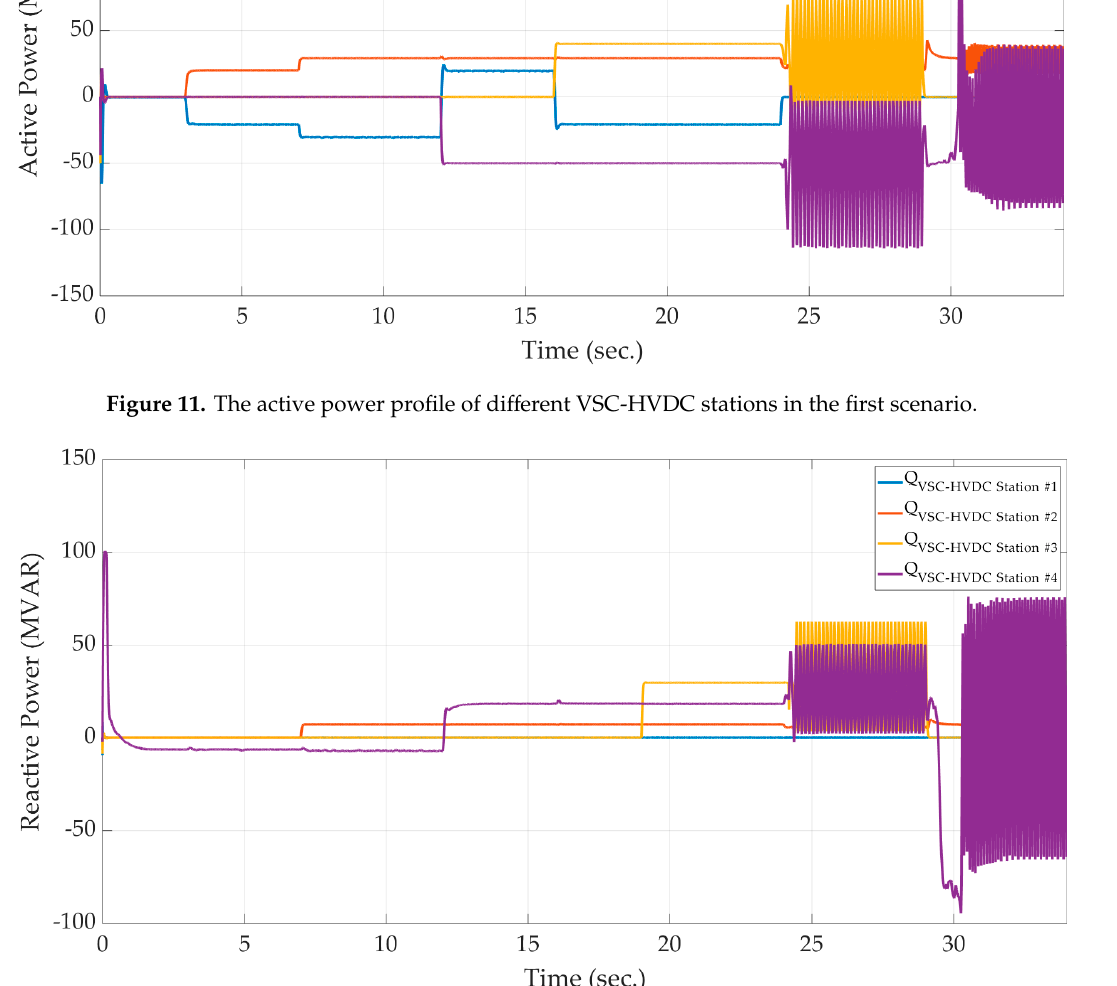
ff erent VSC-HVDC stations in the first Figure 12. The reactive power profile of different VSC-HVDC stations in the first scenario. Figure 12. The reactive power profile of di